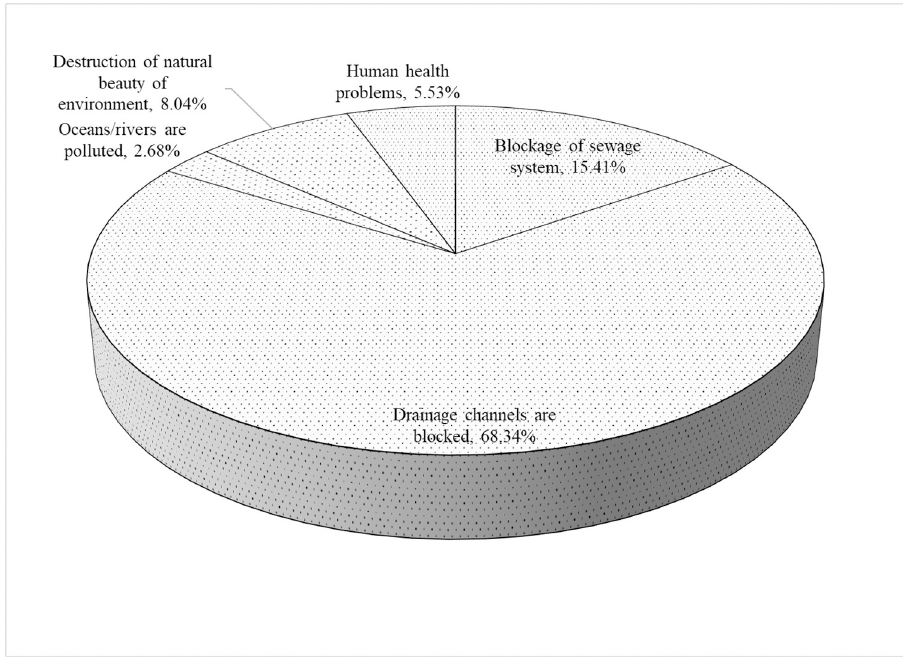
Fig 4. Opinion of the respondents regarding the most severe environmental problems associated with single-use